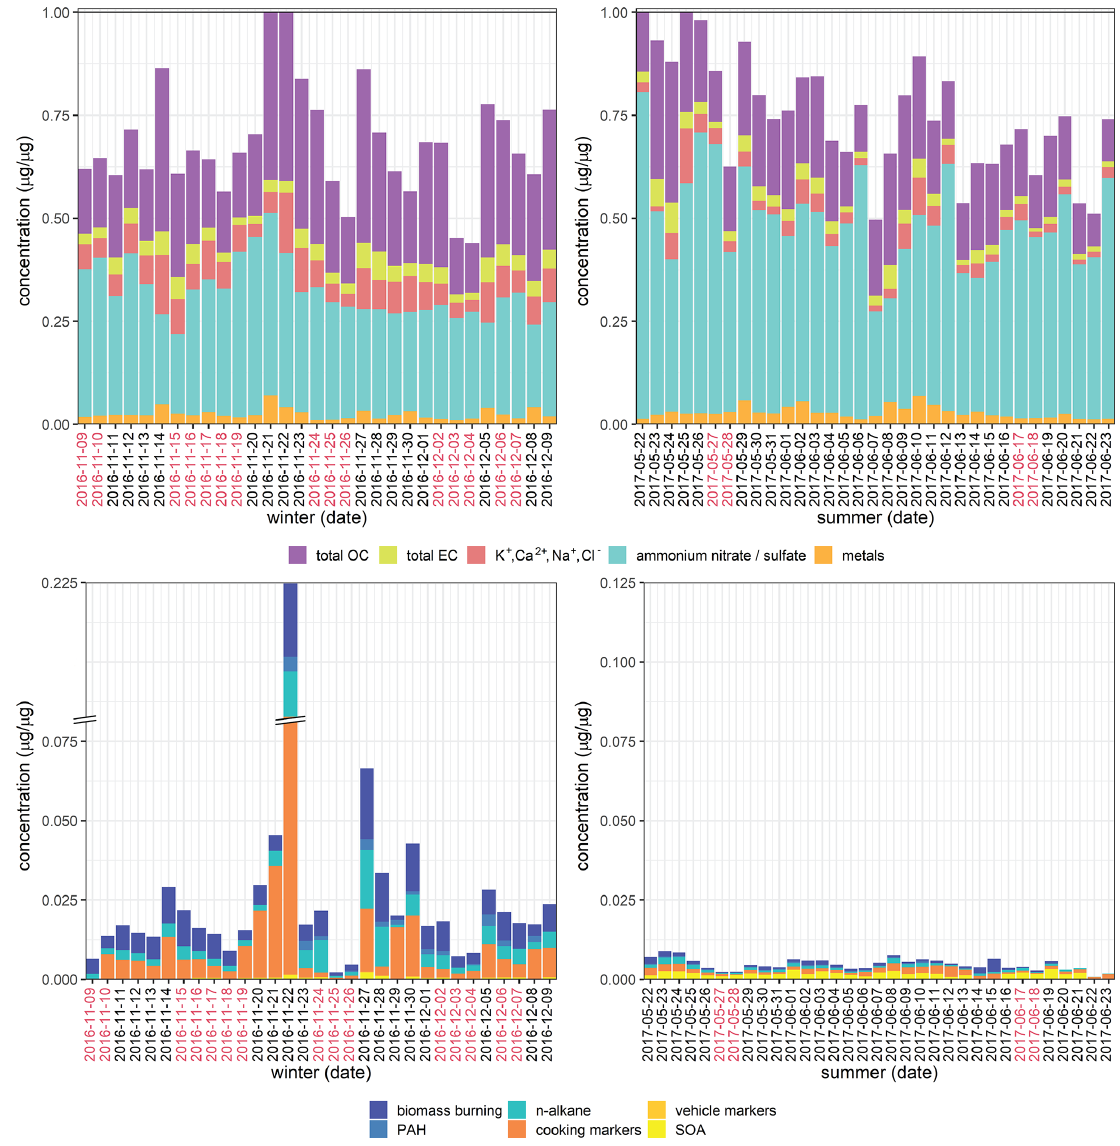
Figure 4. Stacked bar plots of total concentrations for mass-normalised data. OC: organic carbon; EC: elemental carbon; PAH: polycyclic aromatic hydrocarbon; SOA: secondary organic aerosol. “Metals” is the summed concentrations of Al, Ti, V, Cr, Mn, Fe, Co, Ni, Cu, Zn, Cd, Sb, Ba, Pb; “biomass burning” is the summed concentrations of palmitic acid, stearic acid and cholesterol; “PAH” is the summed concentrations of naphthalene, acenaphthylene, acenaphthene, fluorene, phenanthrene, fluoranthene, pyrene, benzo(a)anthracene, chry- sene, benzo(b)fluoranthene, benzo(k)fluoranthene, benzo(a)pyrene, indeno(1,2,3-cd)pyrene, dibenzo(a,h)anthracene and benzo(ghi)perylene; “ n -alkane” is the summed concentrations of C24, C25, C26, C27, C28, C29, C30, C31, C32, C33 and C34; “cooking markers” is the summed concentrations of palmitic acid, stearic acid and cholesterol; “vehicle markers” is the summed concentrations of 17a(H)- 22,29,30-trisnorhopane (C27a) and 17b(H),21a(H)-norhopane (C30ba); “SOA” is the summed concentrations of 2-methylthreitol, 2- methylerythritol, 2-methylglyceric acid, cis -2-methyl-1,3,4-trihydroxy-1-butene, 3-methyl-2,3,4-trihydroxy-1-butene, trans -2-methyl-1,3,4- trihydroxy-1-butene, C5-alkene triols, 2-methyltetrols, 3-hydroxyglutaric acid, cis -pinonic acid, acid, MBTCA, β -caryophyllinic acid, glu- taric acid derivative, 3-acetylpentanedioic acid, 3-acetylhexanedioic acid, 3-isopropylpentanedioic acid and 2,3-dihydroxy-4-oxopentanoic acid. Dates marked in red indicate partial or total day haze events as described in Shi et al. (2019). Measurement uncertainty values were unavailable for most data types, and for selected dates in the upper plots, the sum of the total mass measurements is slightly more than 1 (i.e. more than 1µg per µg); for these dates, the data have been proportionately scaled. It should be noted that the OC measurement in the upper plots incorporates the variety of organic carbon species represented in the lower